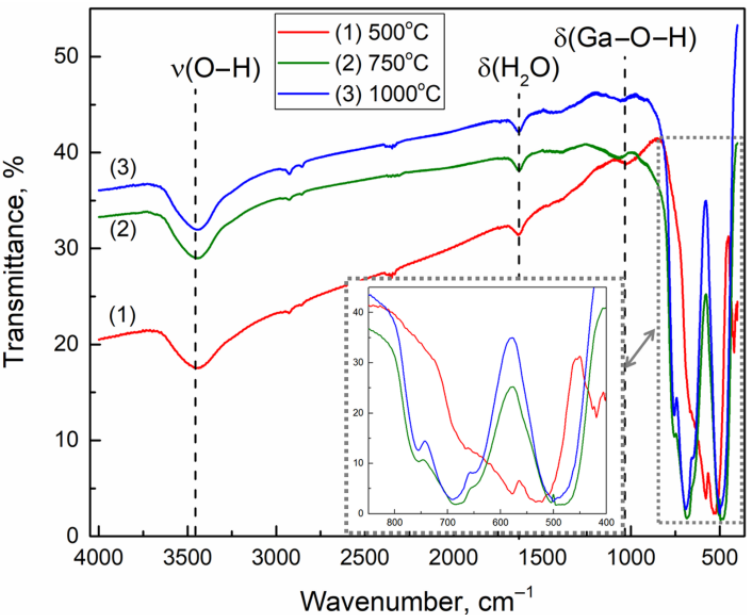
Figure 7. The FTIR spectra of Ga 2 O 3 samples annealed at 500 ( 1 ), 750 ( 2 ) and 1000 °C ( 3 ). The inset shows the data in the range of 400–850 cm − 1 .